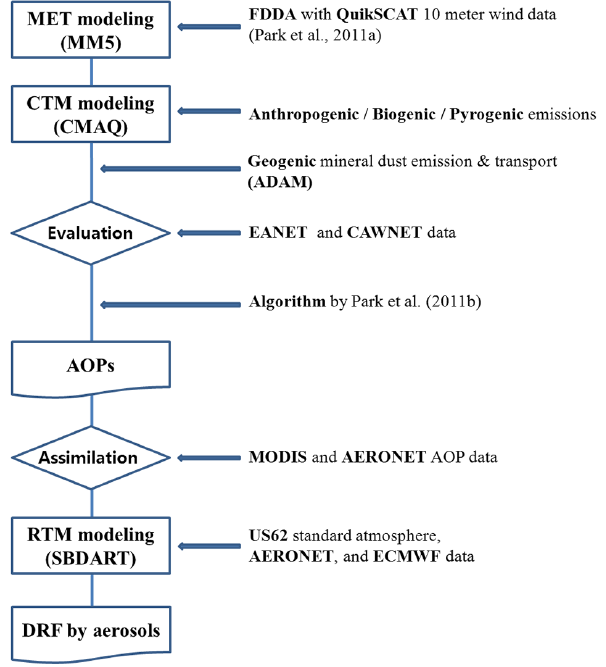
Fig. 1. Flow diagram of the procedures of this study, including (1) meteorological modeling, (2) US EPA Models-3/CMAQ v4.5.1 modeling, (3) ADAM modeling, (4) assimilations of wind data and aerosol optical properties (AOPs), and (5) SBDART radiative trans- fer